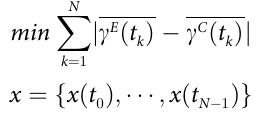
The optimal influx and uptake rates together with the normalized L listed in the Table 2. Method convergence for the cases with best and worst GoF (both from ROI#1) is shown in Fig D in S1 Text . Time